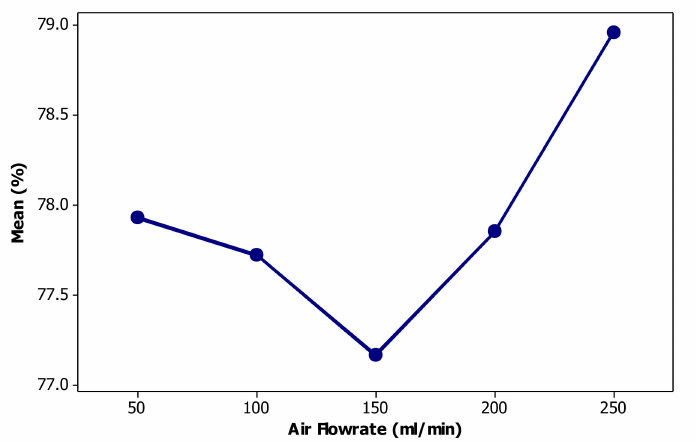
Figure 11. Effect of air flowrate on the performance of removing chromium through the bio-flotation